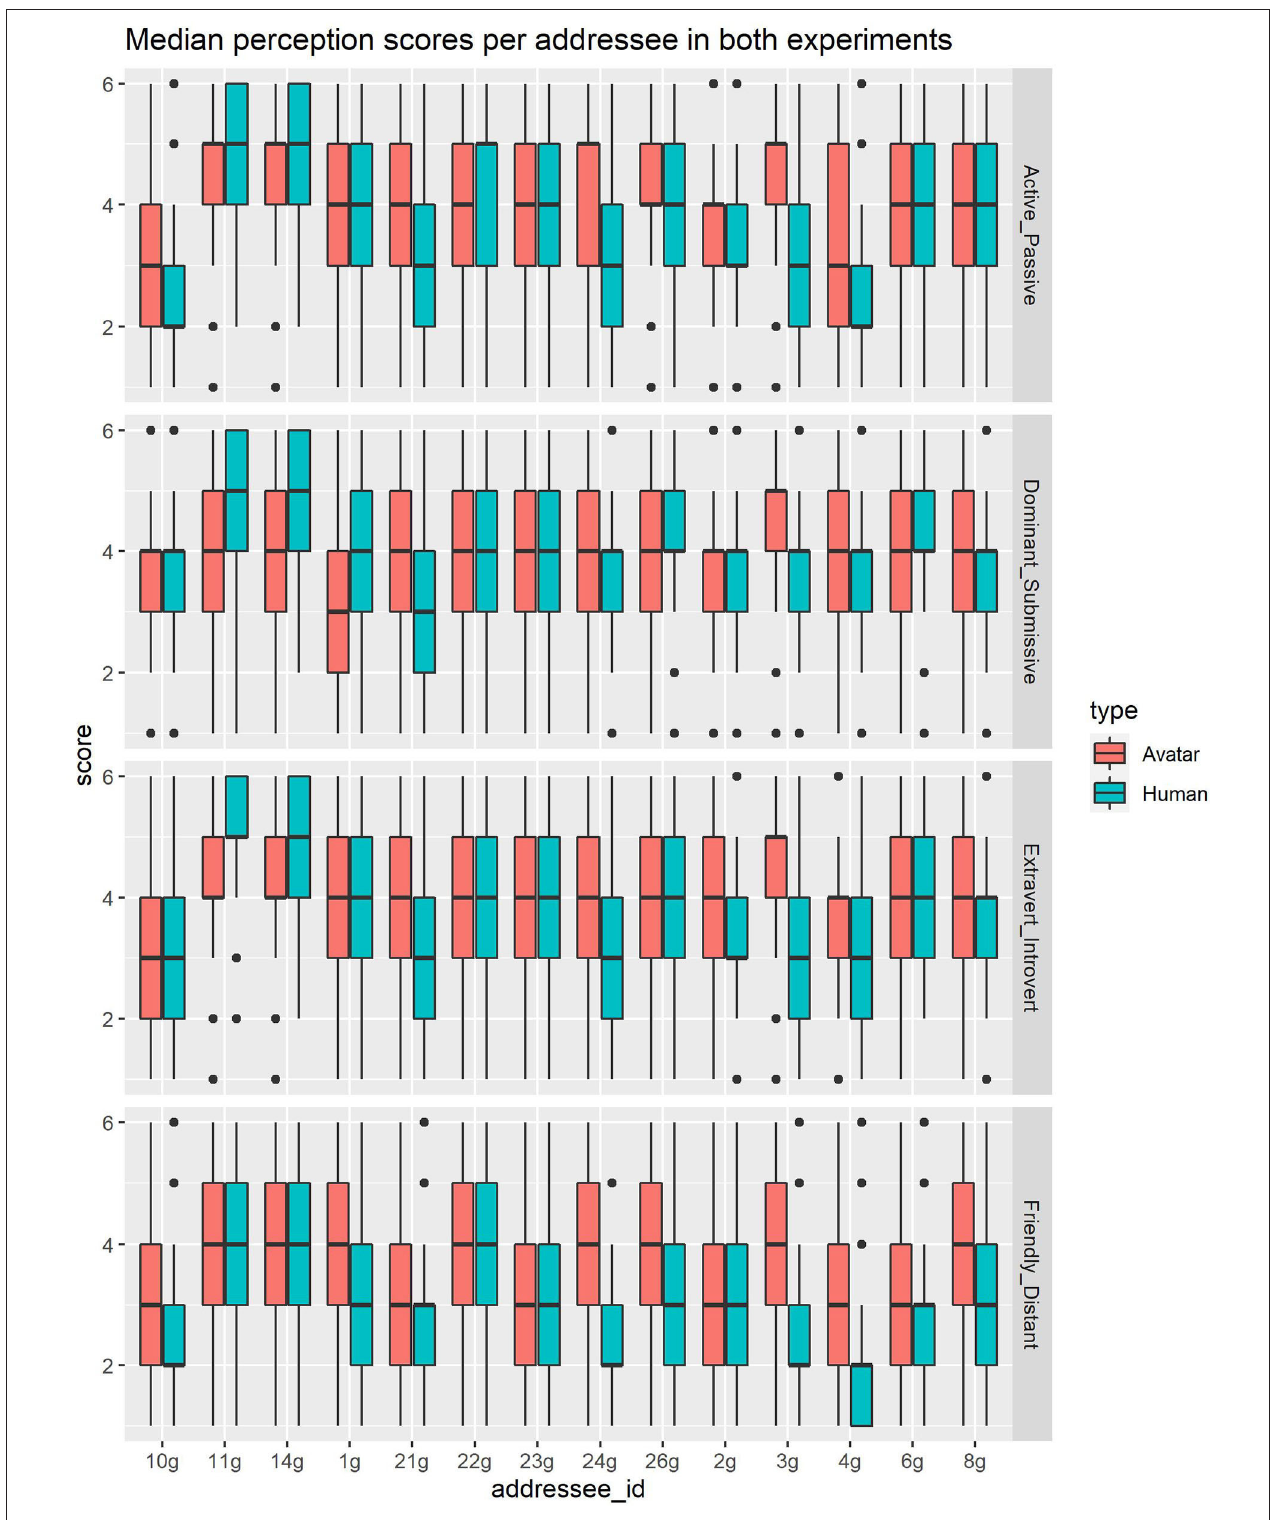
FIGURE 5 | Overview of perception scores for all original addressees in experiment 1 and 2.